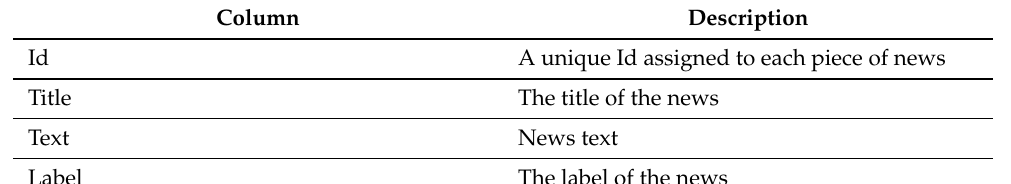
Table 1. Description of the dataset.